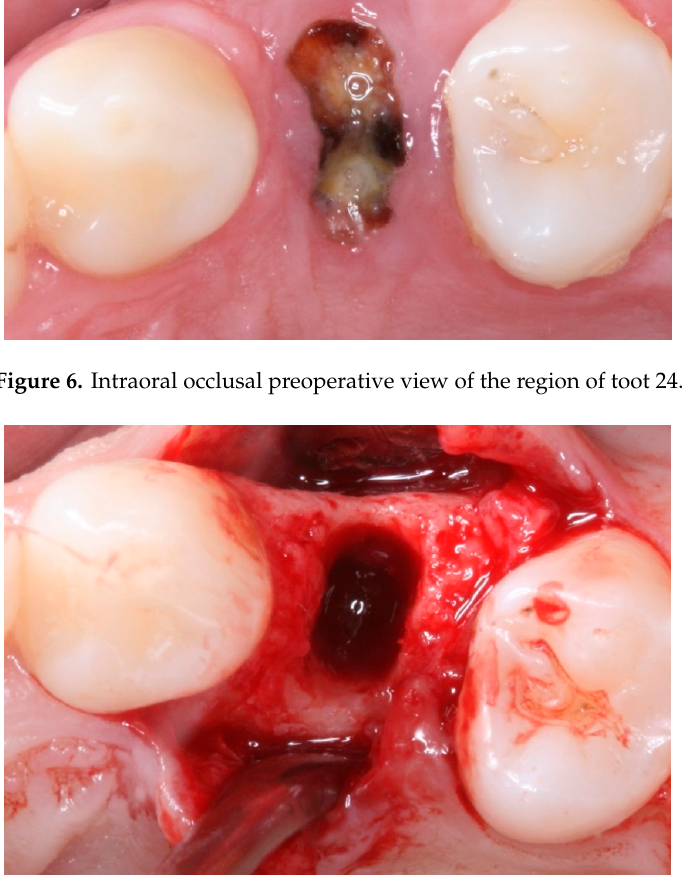
Figure 7. Intraoral occlusal view after extraction of tooth 24 (TG2).